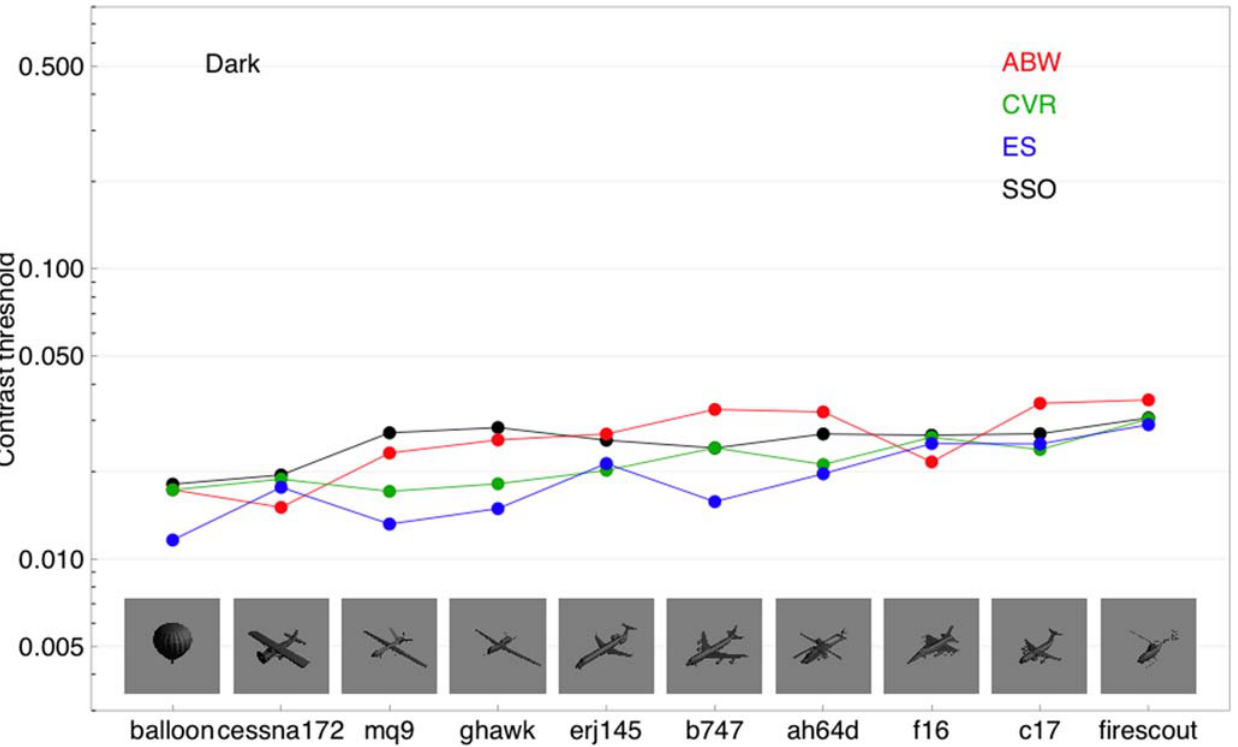
Figure 9. Contrast thresholds for three observers for ten different aircraft. All the aircraft have negative contrast (are darker than the background). Actual aircraft images are shown in the figure. The black points are SSO predictions. The data are sorted from left to right according to the mean threshold for the three observers. doi:10.1371/journal.pone.0005594.g009 PLoS ONE |